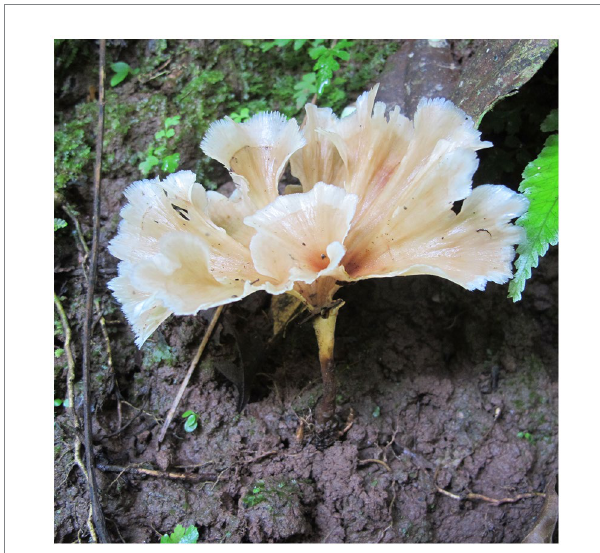
FIGURE 7 Basidiomata of Podoscypha tropica